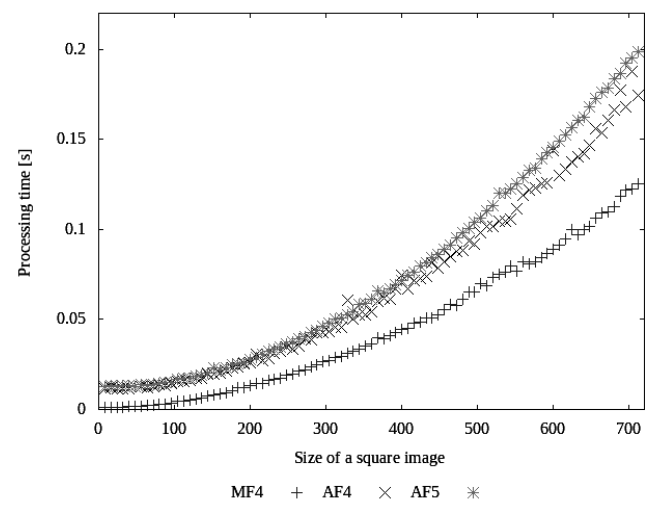
Figure 17. Processing times of MF4 , AF4 , and AF5 models for square images of different sizes. As in the case of the standard training and test process, these results were achieved using